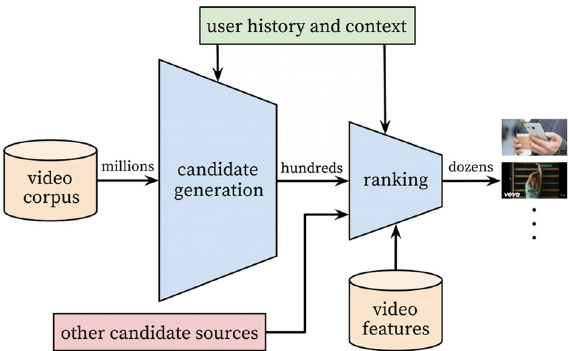
Fig. 4 Recommendation System. Diagram from YouTube engineers indicating how the recommendation system works (reproduced with